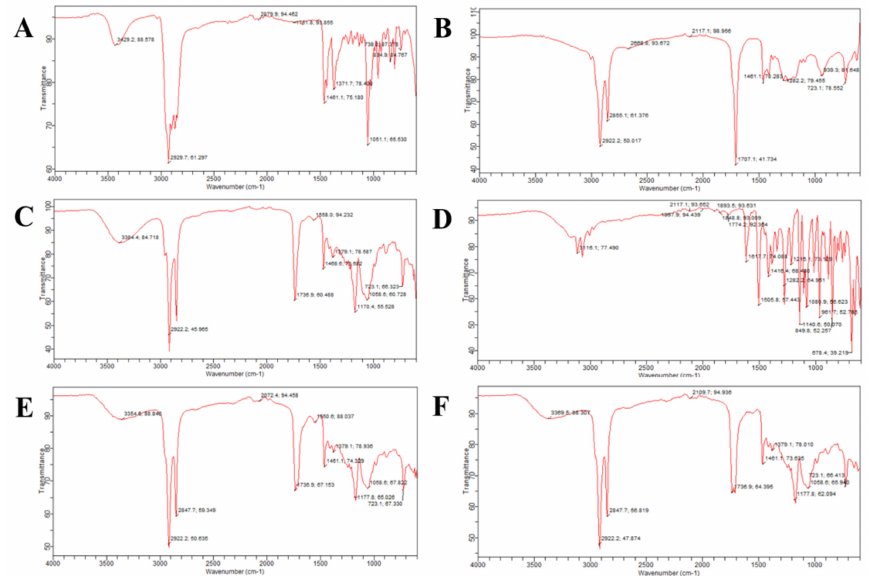
Figure 3. FTIR spectra of cholesterol ( A ), oleic acid ( B ), Span 60 ( C ), FLZ ( D ), drug-unloaded FN7 ( E ) and FLZ-loaded FN7 ( F ).